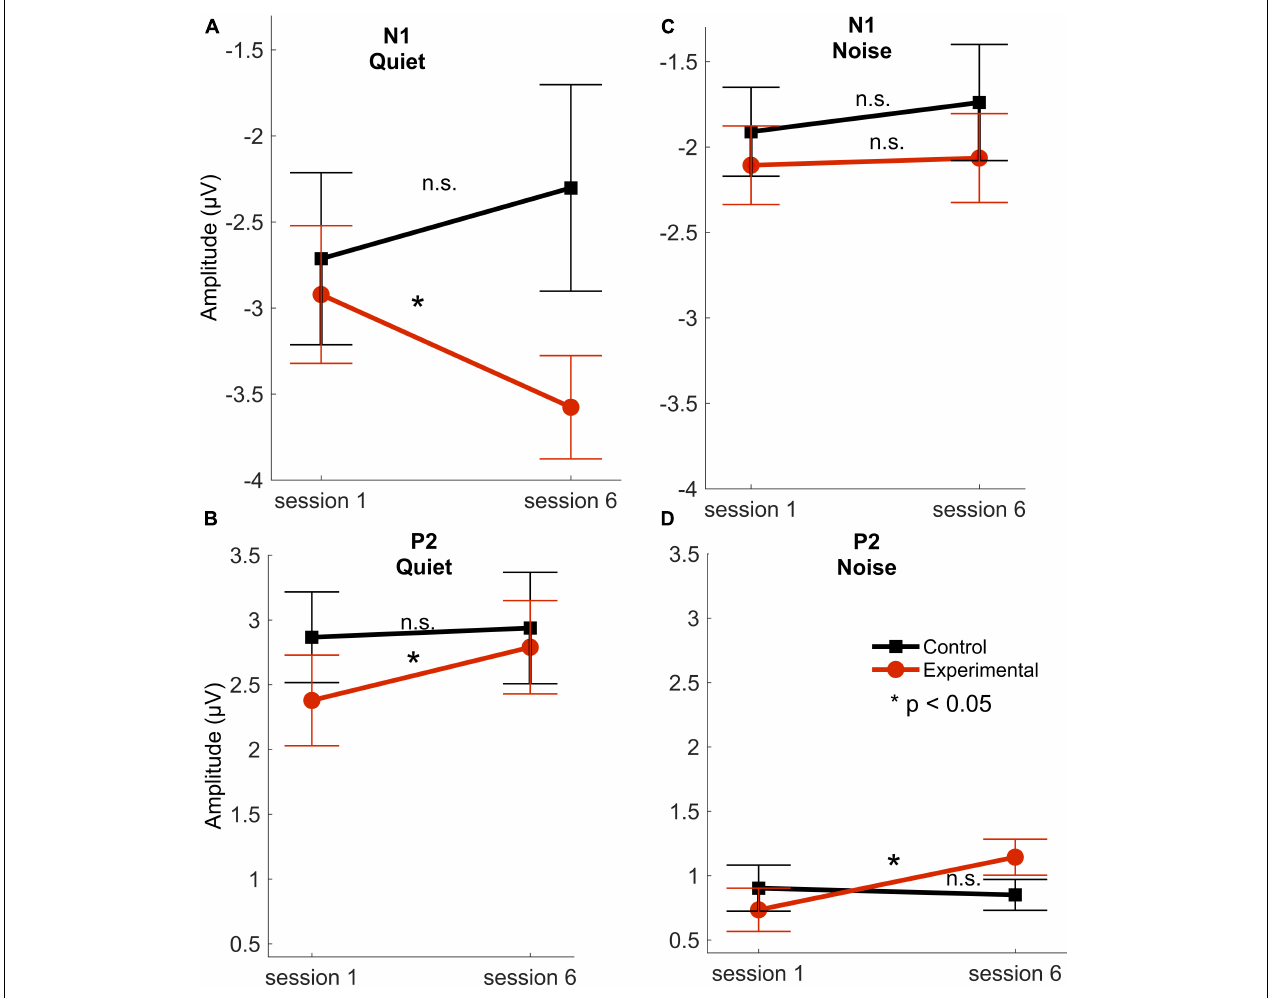
FIGURE 3 | Response amplitudes. N1 and P2 mean amplitudes for the experimental (red circles) and control (black squares) groups across sessions 1 (first) and 6 (last) in quiet (A,B) and noise (C,D) conditions. Error bars represent standard error of the mean. * P < 0.05. n.s, not significant. There were no significant differences between the control and experimental groups in session 1 in any of the cortical amplitudes in quiet [N1: t (29) = 0.665, p = 0.511; P2: t (29) = 1.331, p = 0.194] or in noise [N1: t (29) = 0.597, p = 0.555; P2: t (29) = 0.505, p = 0.617] (modified with permission from Karawani et al.,